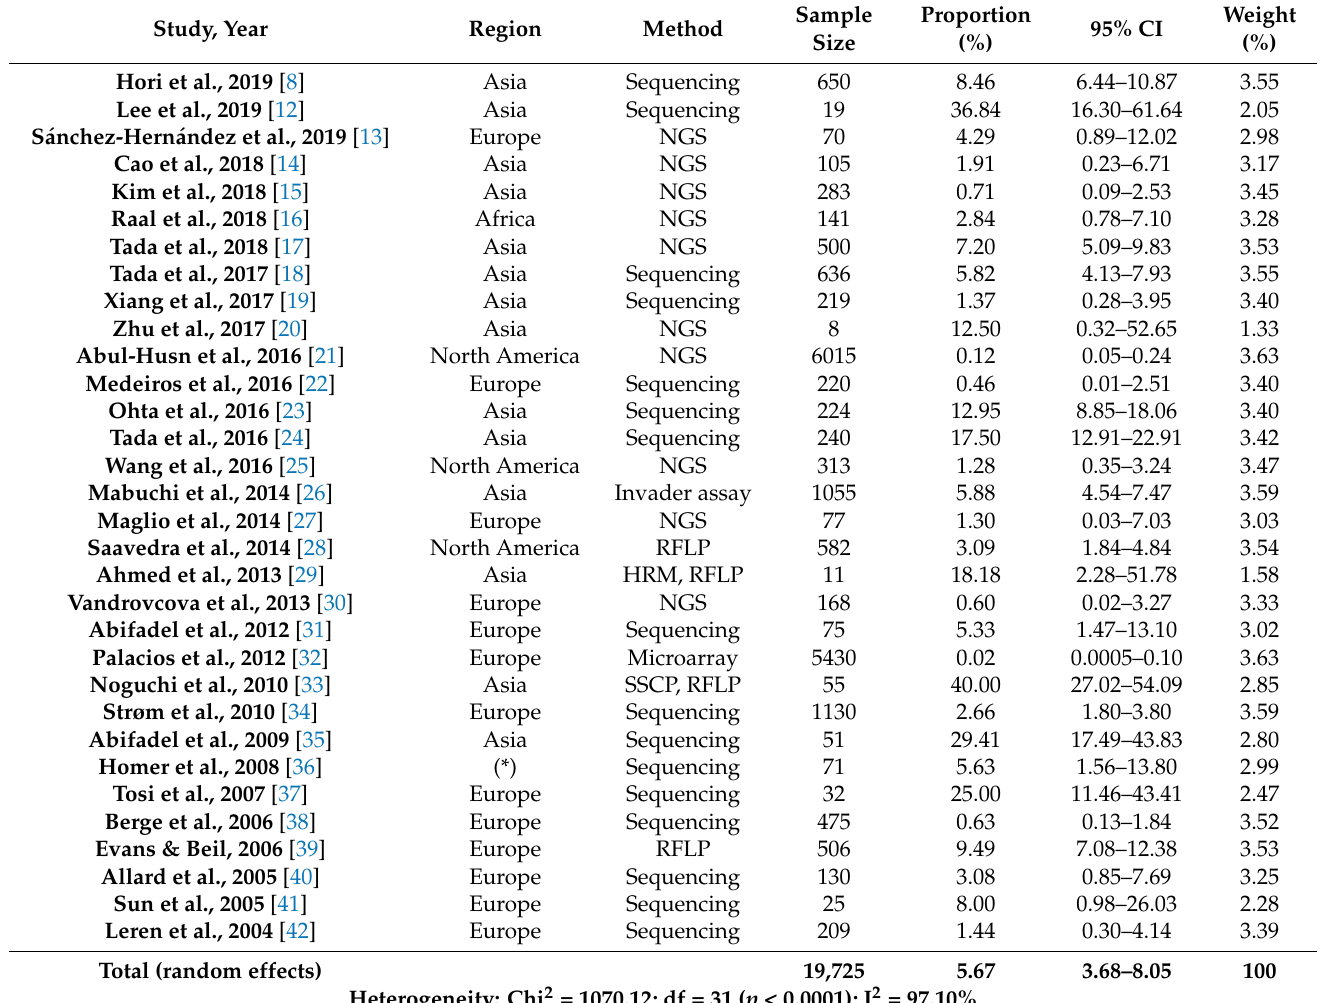
Table 1. PCSK9 mutation proportion of unrelated FH patients group.